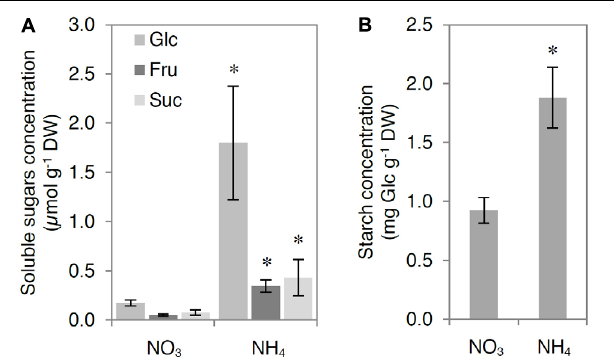
FIGURE 2 | Influence of ammonium (NH 4 + ) nutrition on carbohydrate levels. Concentration of (A) glucose (Glc), fructose (Fru), sucrose (Suc), and (B) starch. Leaf samples of nitrate (NO 3 − )-grown and NH 4 + -grown plants were collected after 4 h of illumination. Values are the mean ± standard deviation (SD) of 4 biological and 2 technical replicates. Significant differences ( P ≤ 0.05) between NO 3 − -grown and NH 4 + -grown plants are indicated by an asterisk ( ∗ ).